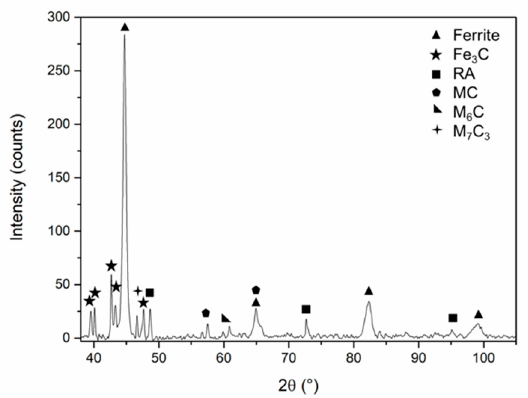
Figure 5. XRD di ff ractogram recorded on the bulk taps after Figure 5 . XRD diffractogram recorded on the bulk taps after CHT_5.